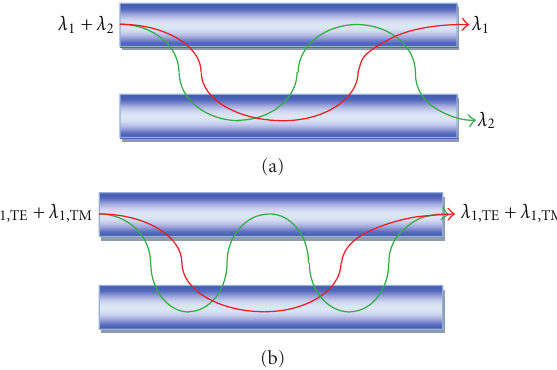
Figure 1: Illustration of input with (a) di ff erent wavelengths exiting at di ff erent ports (wavelength splitting) and (b) di ff erent polariza- tions for a single wavelength exiting at the same